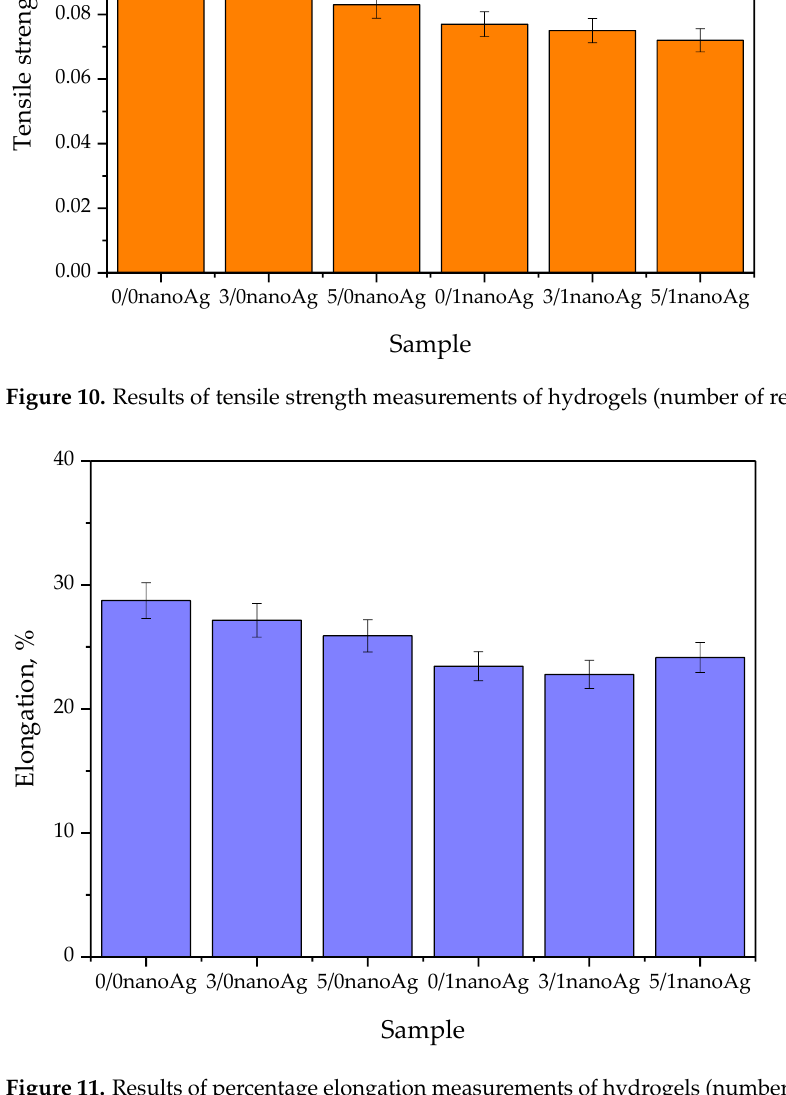
Figure 11. Results of percentage elongation measurements of hydrogels (number of repetitions n = 3).